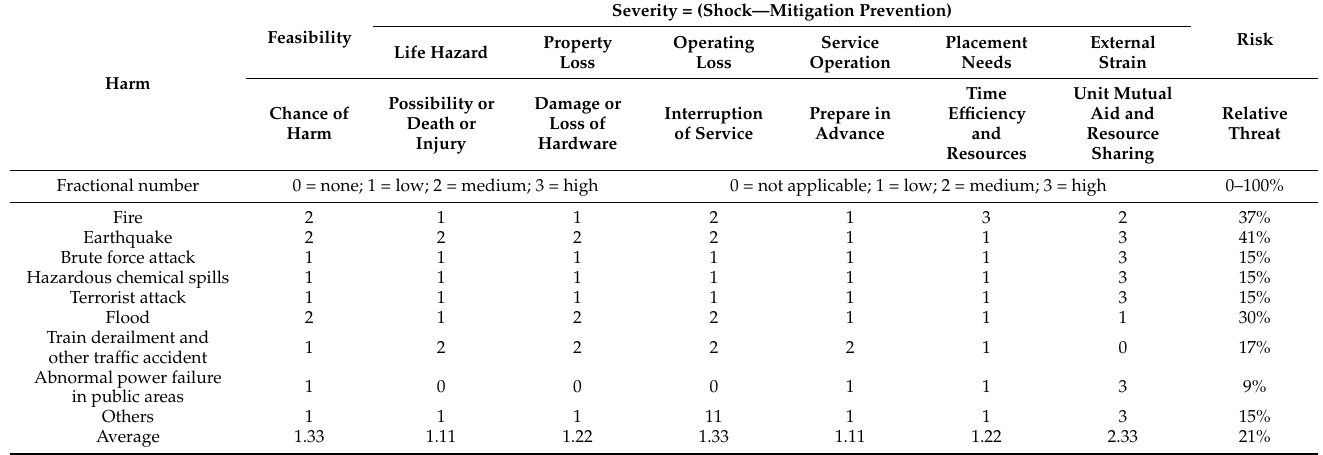
Table 6. Disaster risk assessment table.